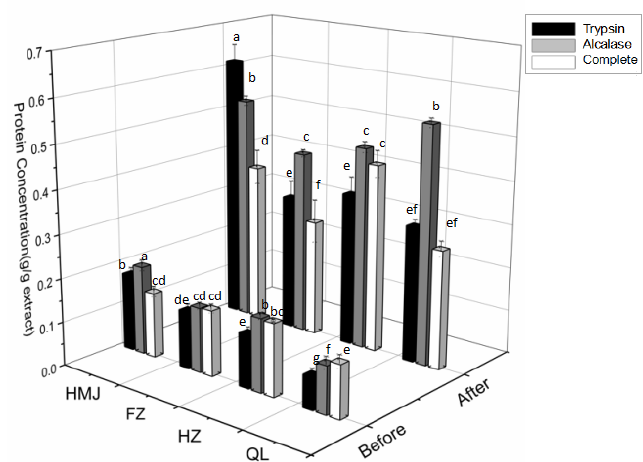
Fig. 1: Protein concentrations of four kinds of dark tea extracts and their hy- drolysates before and after purification treatments. Mean ± SD (n=3). Bars with different letters are significantly different at p < 0.05.